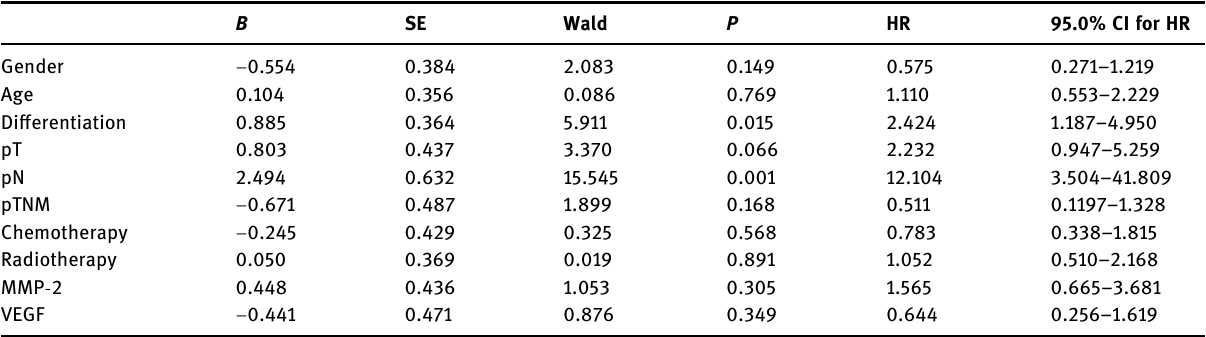
Table 3: Results of Cox regression multivariate 5 - year survival analysis of the patients with adenocarcinoma of the esophagogastric